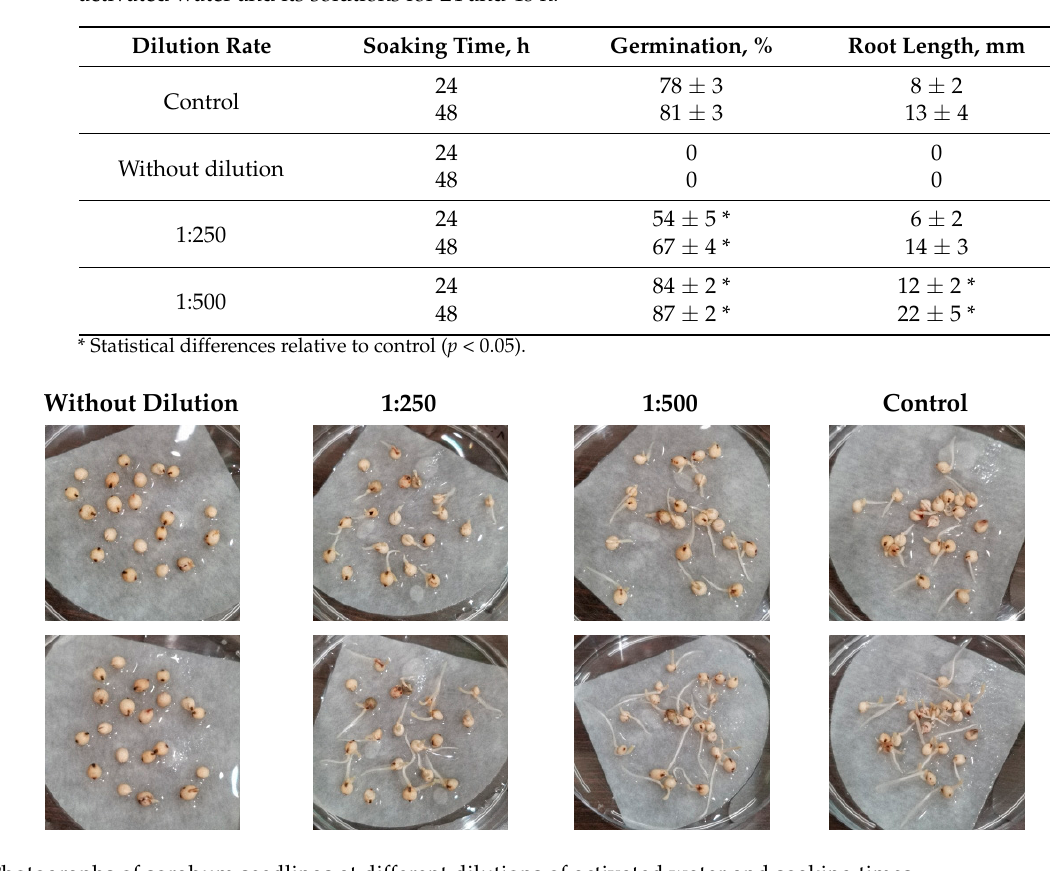
Table 5. The main parameters of sorghum seedlings after 120 h from the moment of soaking in activated water and its solutions for 24 and 48 h.